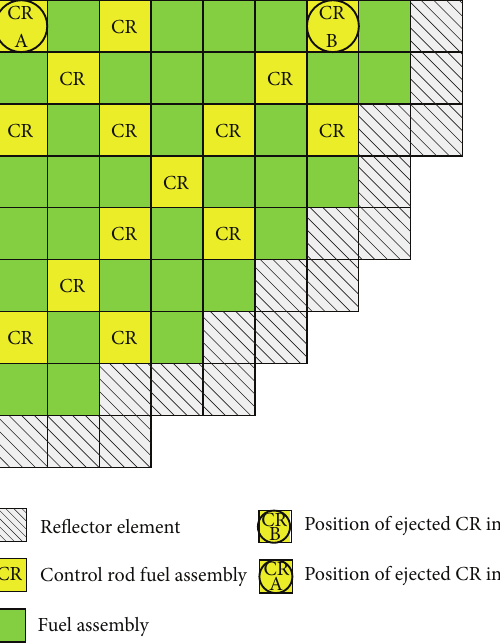
Figure 1: PWR NEACRP core model of cases A and B